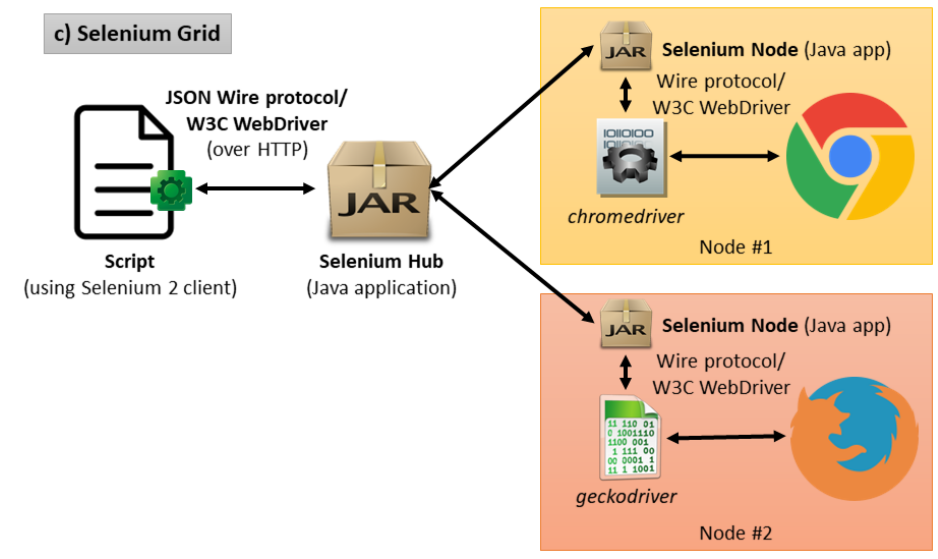
Figure 2. Selenium Grid